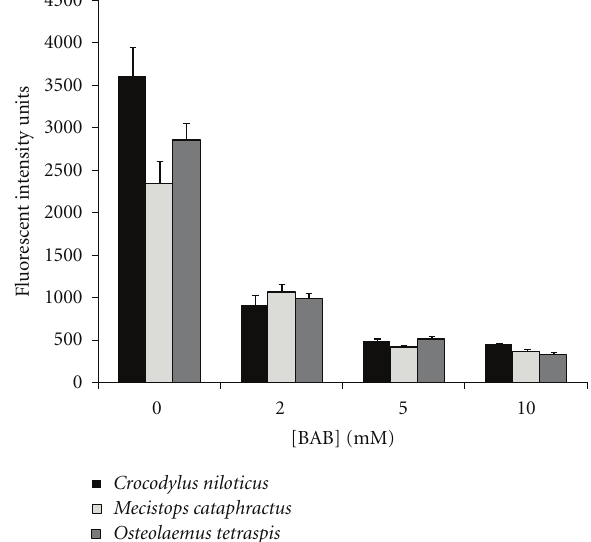
Figure 2: The e ff ects of p-bromophenacyl bromide, a specific PLA 2 inhibitor, on the serum PLA 2 activity of Osteolaemus tetraspis , Mecistops cataphractus , and Crocodylus niloticus . The results rep- resent the means ± standard deviations of four independent determinations.